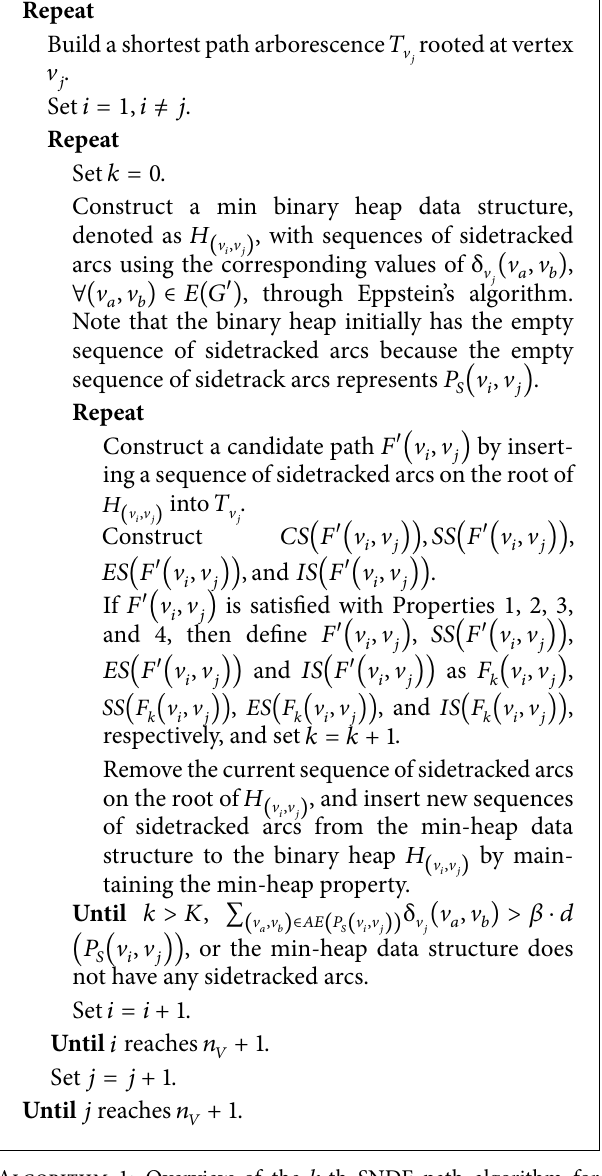
Algorithm 1: Overview of the constructing at most